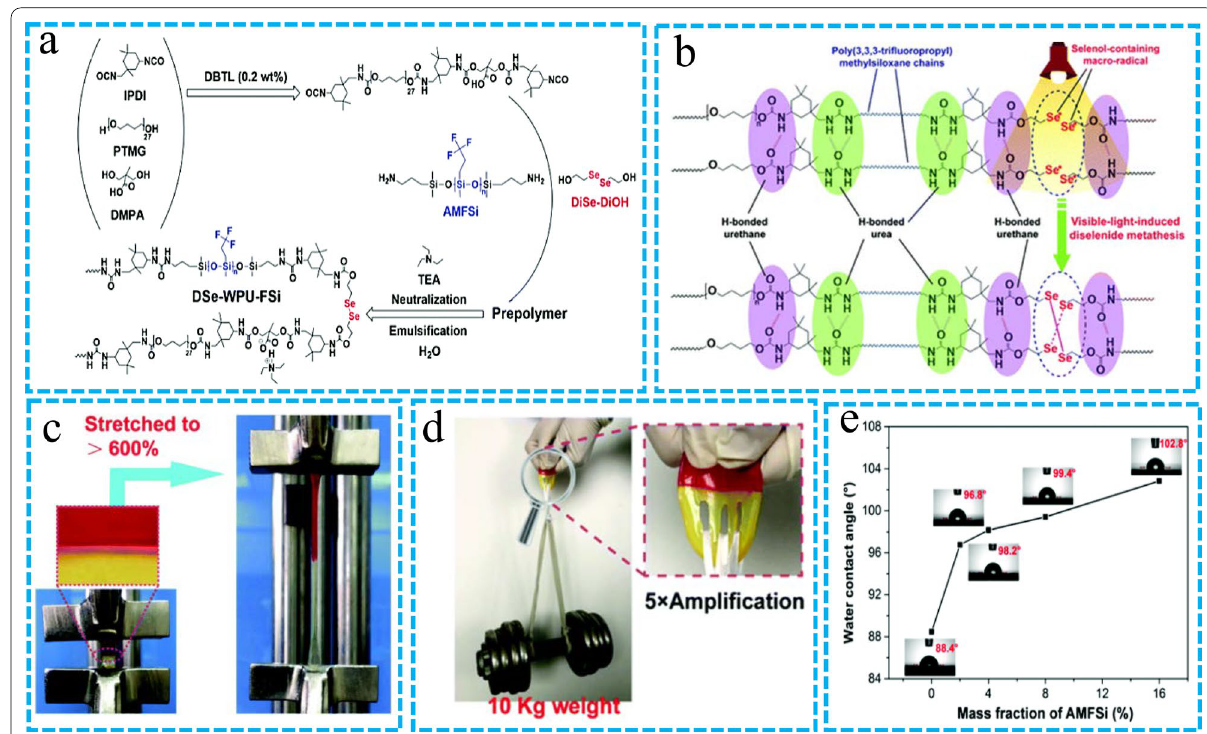
Fig. 3 a Synthetic path of the emulsion (DSe-WPU-FSi). b Visible light-responsive healing mechanism of film (DSe-WPU-FSi). c The film sample(DSe-WPU-FSi) after self-healing could be stretched to more than 600%. d The round DSe-WPU-FSi film after healing lifted up a weight